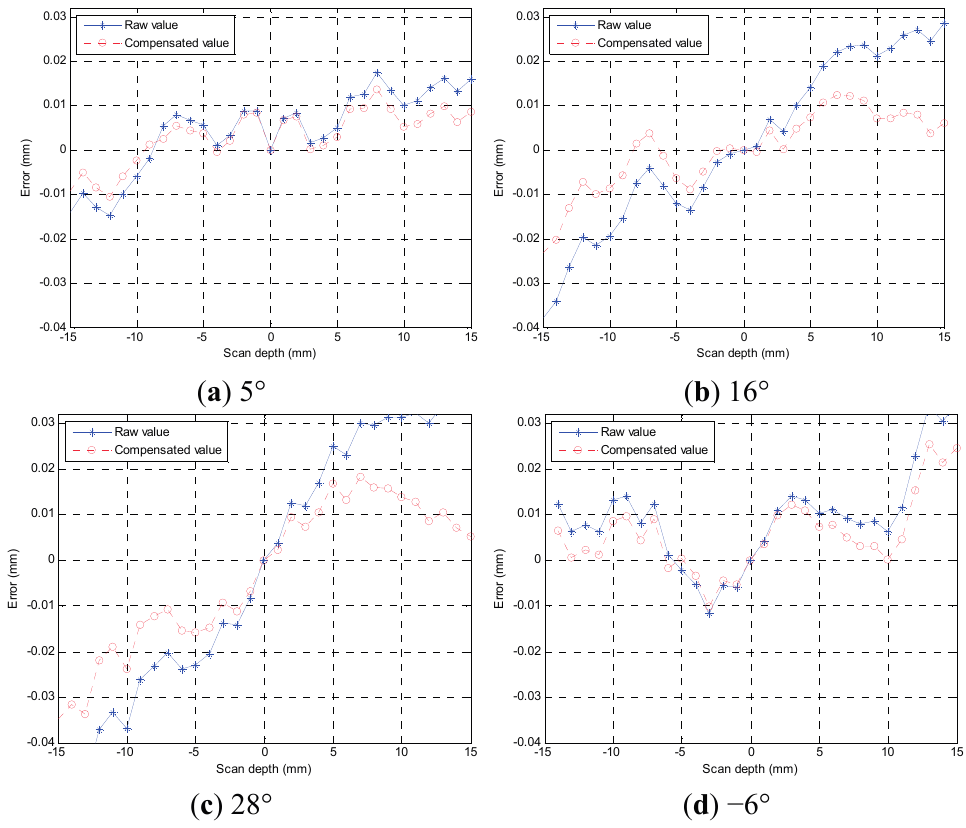
Figure 9. Inclination angle errors and compensation